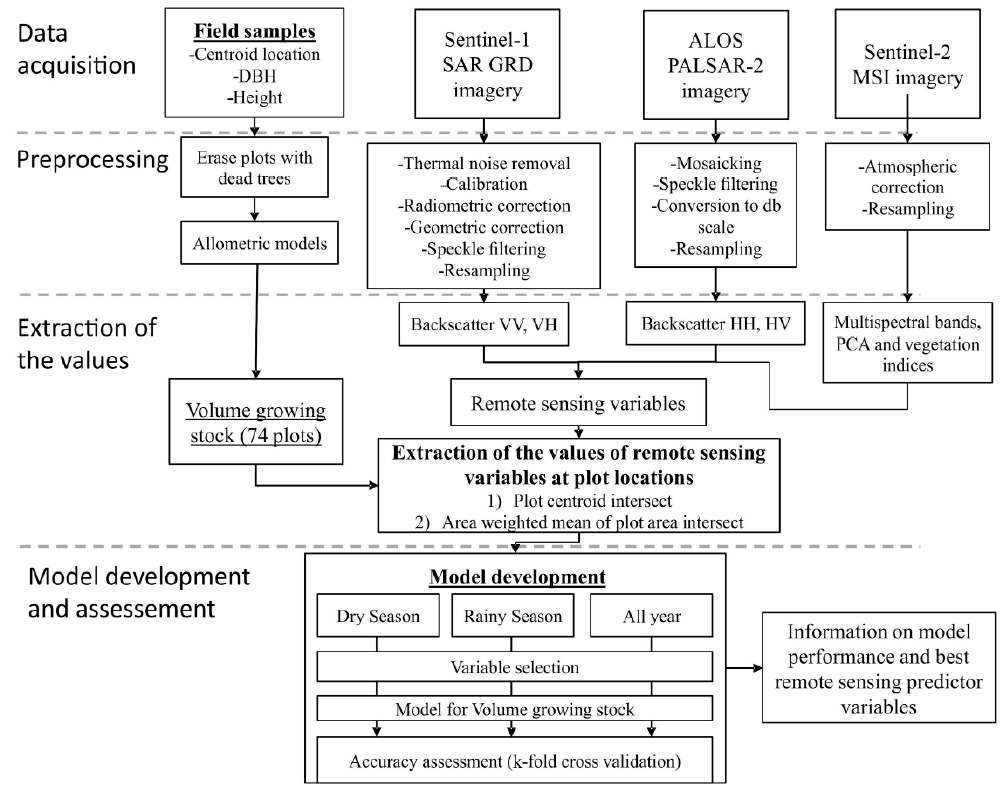
Figure 2. Workflow of the study illustrated in 4 phases.